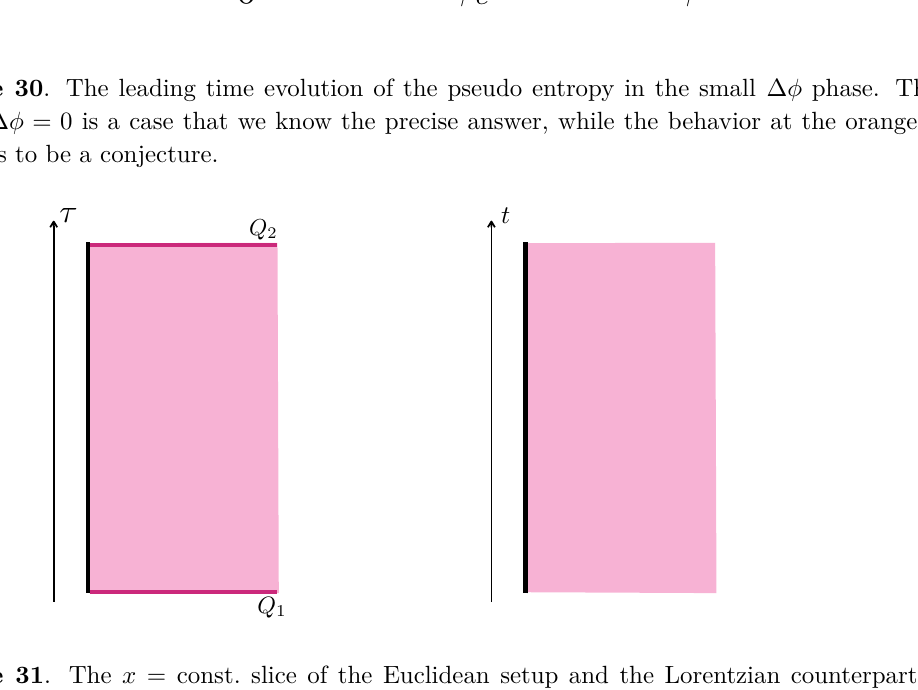
Figure 31 . The x = const . slice of the Euclidean setup and the Lorentzian counterpart of the large ∆ phase. The Lorentzian turns out to be a static thermal AdS with temperature 1 / (2 πa ) , and there is non end-of-the-world branes involved in the Lorentzian